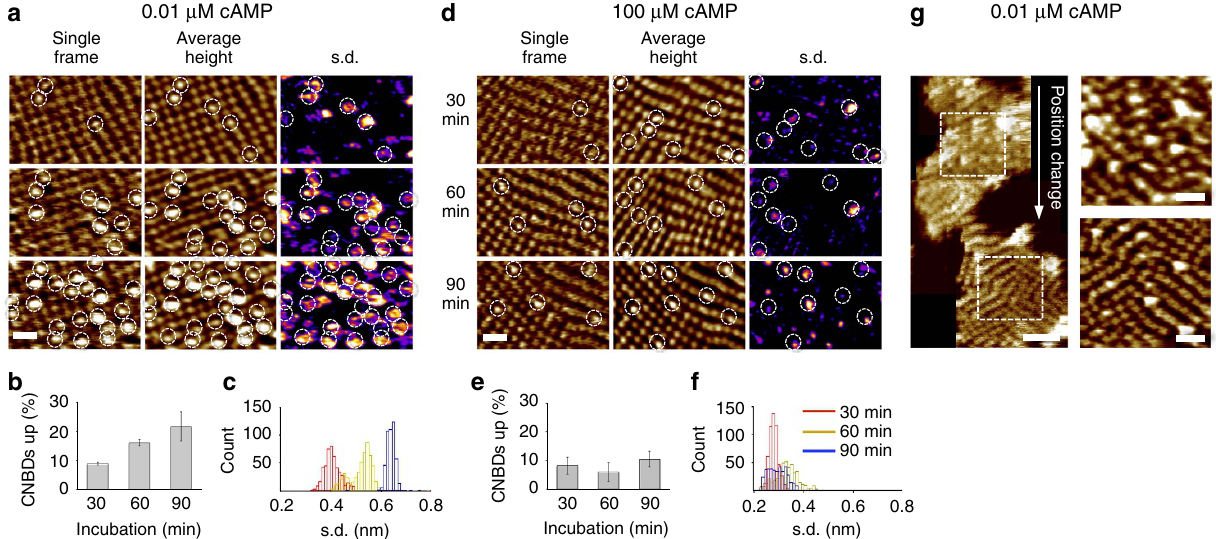
Figure 3 | The number of blinking MloK1 channels increases over time at low ligand concentration. ( a ) Representative membrane imaged after 30 (upper), 60 (centre) and 90 (lower) minutes in 10nM cAMP. For each condition, a single HS-AFM frame (left), the average height (middle) and the s.d. map (right) of the complete movie are shown. Blinking channels are highlighted by circles. While the single frame only shows MloK1s with elevated CNBDs at a given time, the average height-map displays all molecules with elevated heights throughout the movie, and the s.d.-map highlights the pixels changing over time, a hallmark of blinking. ( b ) The percentage of blinking channels in 10nM cAMP plotted as a function of incubation time (mean ± s.d.). ( c ) Histograms of the s.d. of all pixel values in each movie frame from a membrane area of 12,750nm 2 (15,000 pixels) and B 500 frames at 10nM cAMP after 30 (red), 60 (yellow) and 90 (blue) minutes. An increase in the s.d. reflects increased blinking. ( d – f ) as described in a – c , but in the presence of 100 m M cAMP. In contrast to the low-cAMP condition, the number and intensity of blinking molecules stays virtually identical over time. ( g ) The height increase of the CNBD in low cAMP requires an input of energy provided by the AFM tip. The imaged membrane area shows an increasing number of blinking molecules (upper), while most MloK channels are in cAMP-bound conformation in the untouched membrane area (lower). The full colour scales and scale bars are identical for all AFM images and correspond to 3nm ( z ) and 30nm ( x / y